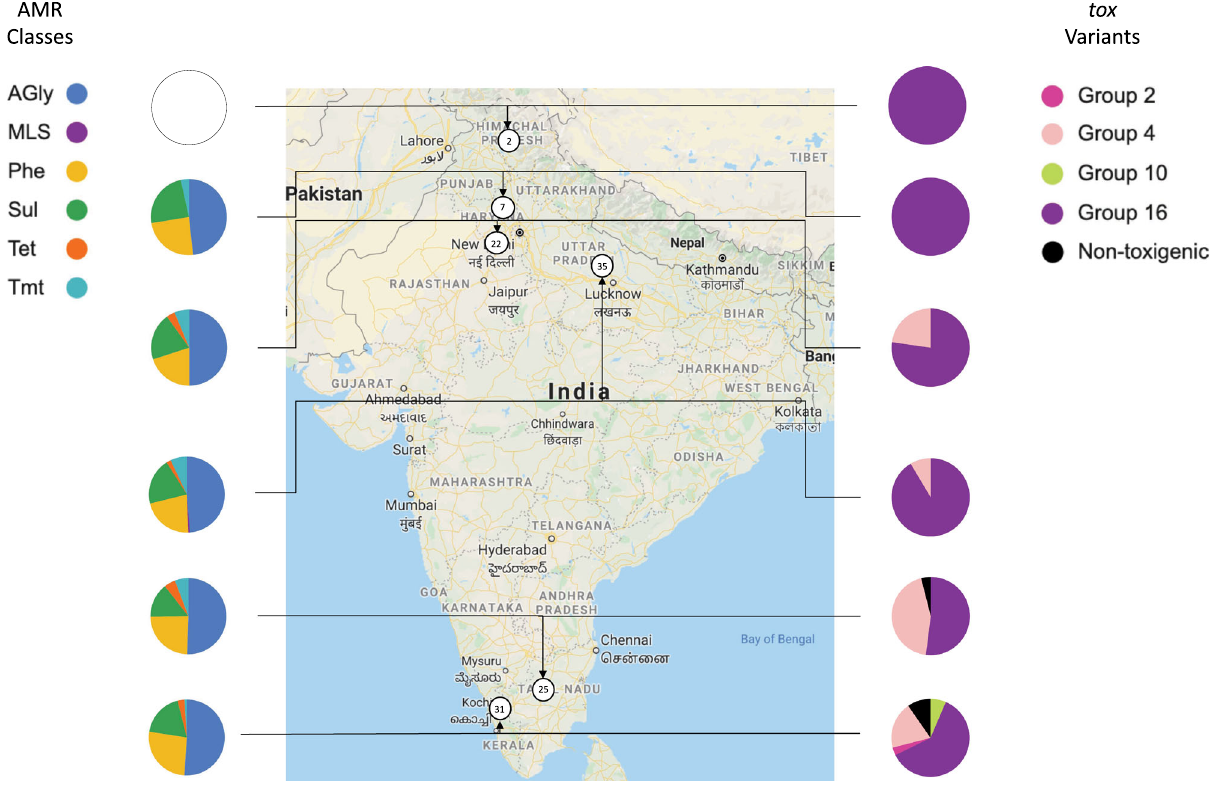
Fig. 3 The antimicrobial resistance (AMR) gene and tox gene variant proportions represented in the 122 Corynebacterium diphtheriae genomes from India at state level. The number of isolates from the six states sampled are shown in circles on the map. The AMR genes are coloured by the classes of antibiotic the genes offer resistance to. AGly (blue) aminoglycosides, MLS (purple) macrolide – lincosamide – streptogramin, Phe (yellow) phenicols, Sul (green) sulfonamides, Tet (orange) tetracyclines, Tmt (light blue) trimethoprim. The map was taken from Google Maps 47